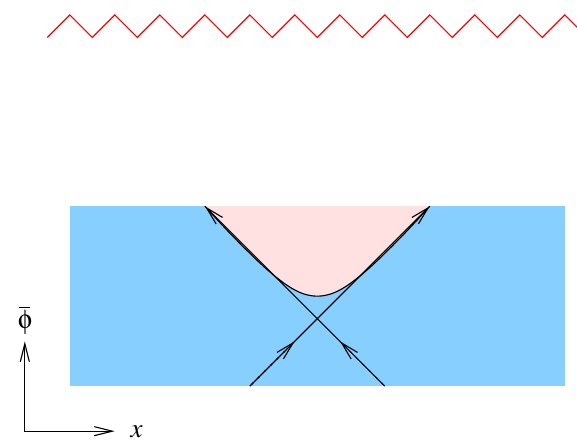
Figure 9. Schematic illustration of timelike FZZT branes and the folded strings with ¯ b > 1 . Since the Liouville field ¯ φ has central charge c < 1 , additional matter must carry c > 25 . Here, we are taking x to be a c = 1 free boson as a part of the c > 25 matter content, with the remaining c > 24 component playing a spectator